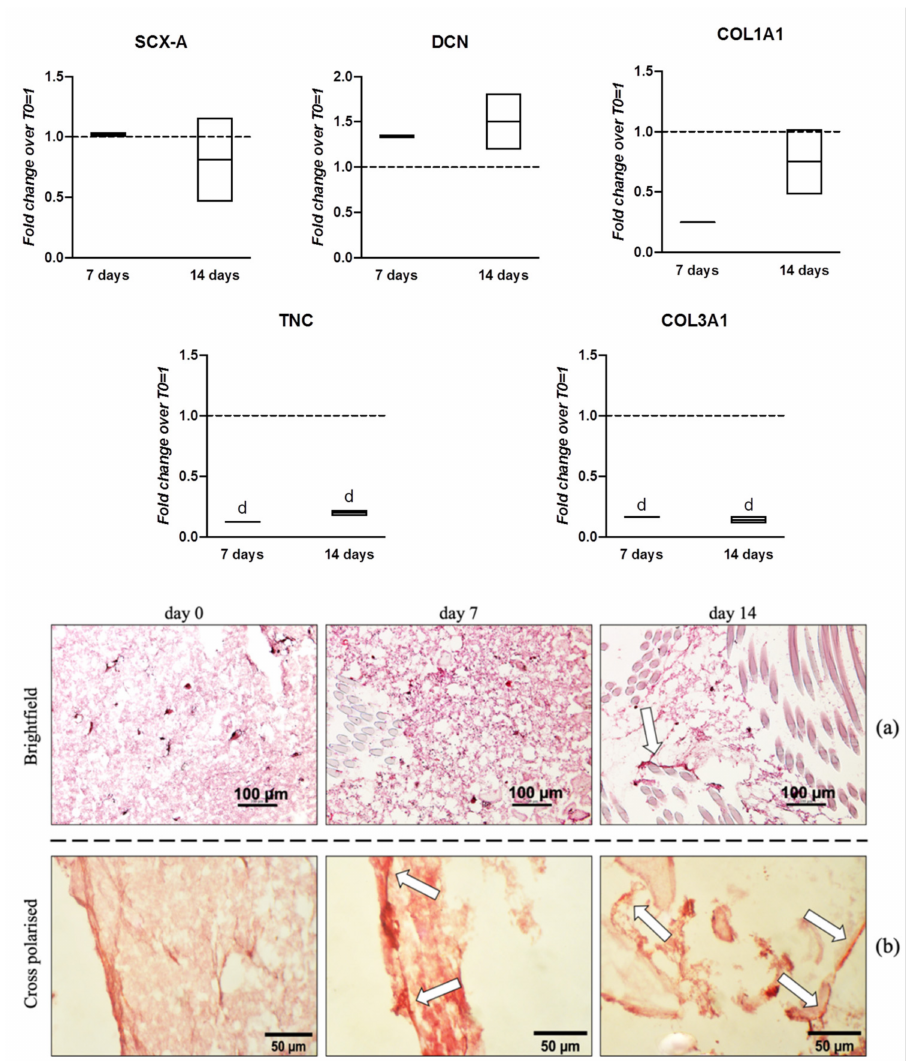
Figure 5. Gene expression profiles and histological characterization of hWJ-MSCs cultured within the 3D construct into a medium supplemented with hGDF-5 with cyclic strain. hWJ-MSCs were cultured up to 14 days. The mRNA levels of different tenogenic markers (COL1A1, SCX-A, DCN, TNC, and COL3A1) were monitored. Relative quantification of each mRNA gene expression normalized to endogenous GAPDH (internal control) was calculated using the 2 − ∆∆ Ct method and presented as fold change over hWJ-MSCs T0 = 1 (dashed line). Statistically significant differences are shown as “d” = p ≤ 0.001 compared to T0; n = 2 (biological replicates). Samples at same time-points were subjected to Sirius Red staining for collagen highlighting. The 3D fibrin matrix showed small areas stained in darker red probably filled with collagen (arrowheads, a ). Polarized microscope revealed few birefringent collagen fibers (arrowheads, b